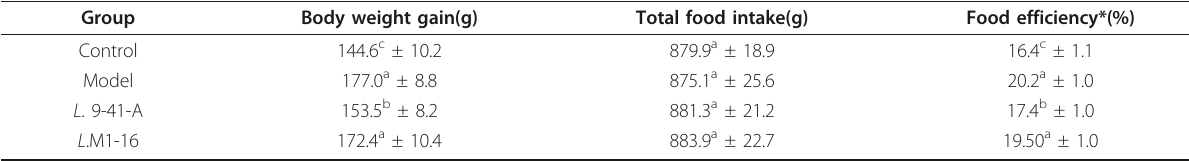
Table 1 Body weight gain, total food intake, and food efficiency (n = 10 per group) after 6